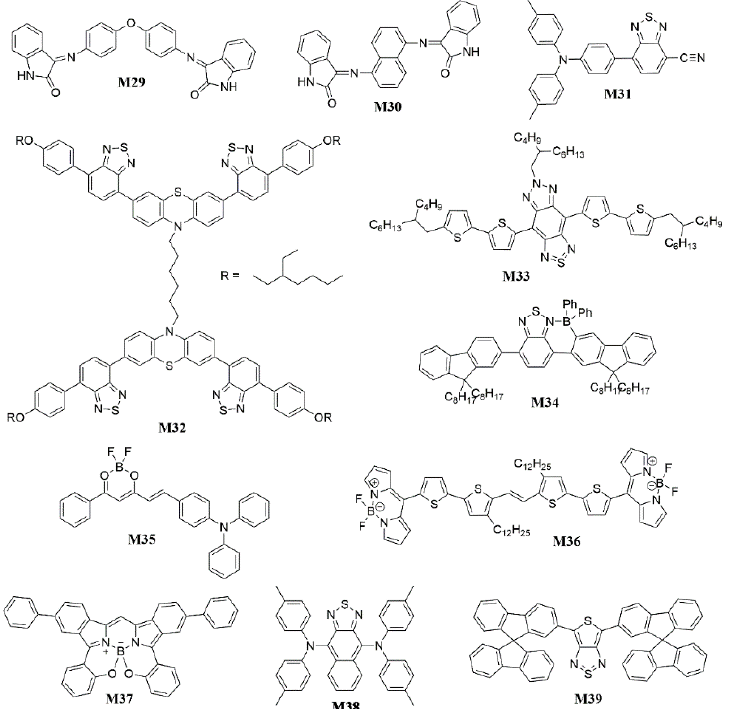
Figure 11. ( a ) Schematic energy band diagrams of EL devices using M24 and M25 as nondoped EML; ( b ) Compared EL spectra of the OLEDs based on M24 and M25 . Insert: photograph of M24 -based device (adapted from ref. [118]).